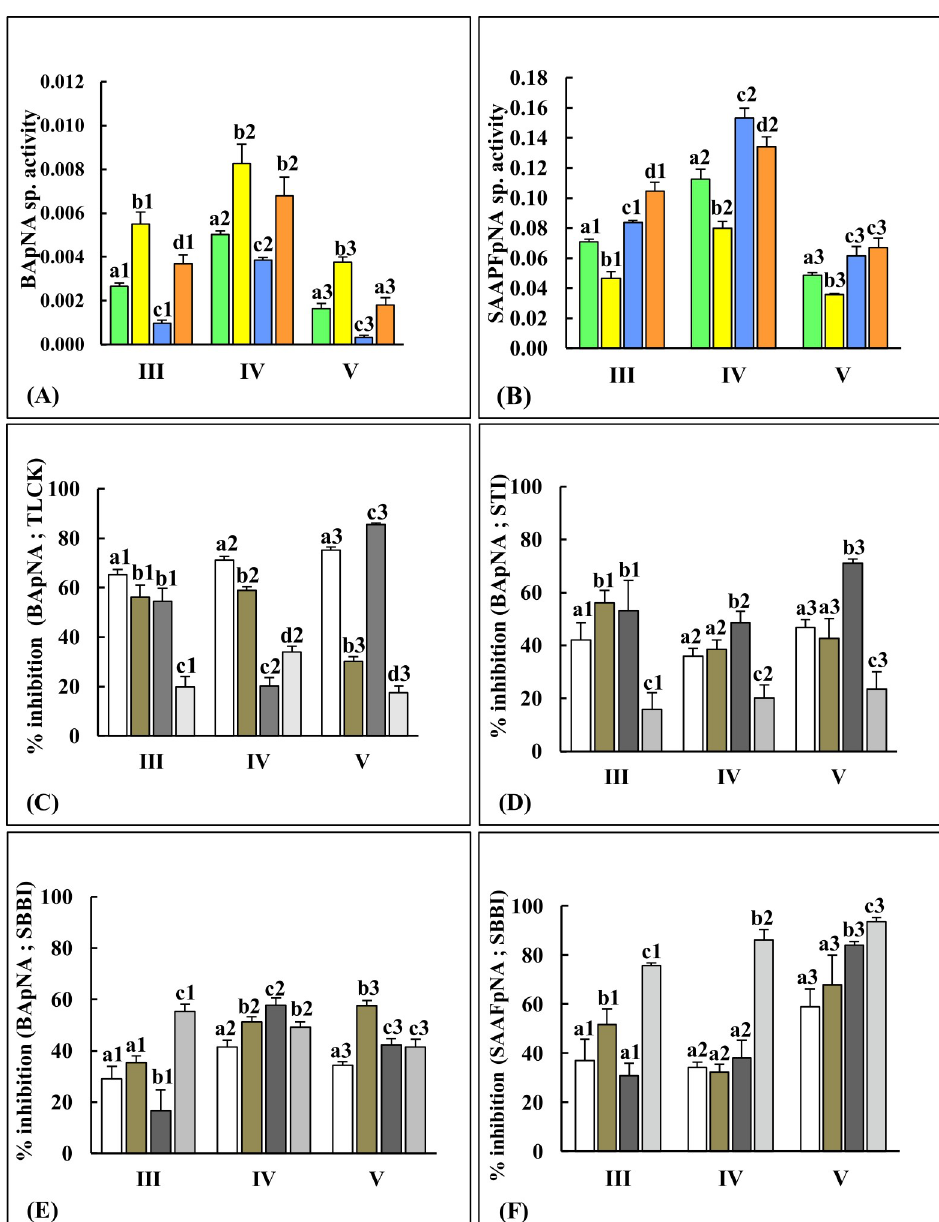
Fig 3. P . brassicae gut trypsin and chymotrypsin activities measured using amidolytic substrates show different trends in larvae from reciprocal switch experiments. Serine protease activities detected using (A) BApNA and (B) SAAPFpNA substrates in III, IV and V instars (n = 36) fed on CF-CF (green), CF-GN (yellow), GN-CF (blue), and GN-GN (orange) diets in no-choice, fixed time experiments. Inhibition of gut trypsin activity by 3 protease inhibitors are shown (Panel C: 10mM TLCK; Panel D: 0.05mM STI, and Panel E: 0.125mM SBBI) while inhibition of gut chymotrypsin activity by 0.125mM SBBI is shown in panel F. The % inhibition is relative to the trypsin and chymotrypsin activity detected in each corresponding gut sample. Bars depict mean ± SE. Significant differences (at p � 0.05, Tukey’s HSD test) are depicted by different letters. the third- and fourth instar were inhibited by only 50% or less by SBBI (Fig 3F). Chymotrypsin activities detected in all gut samples from fifth instar were inhibited by at least 60% and above by SBBI (Fig 3F).